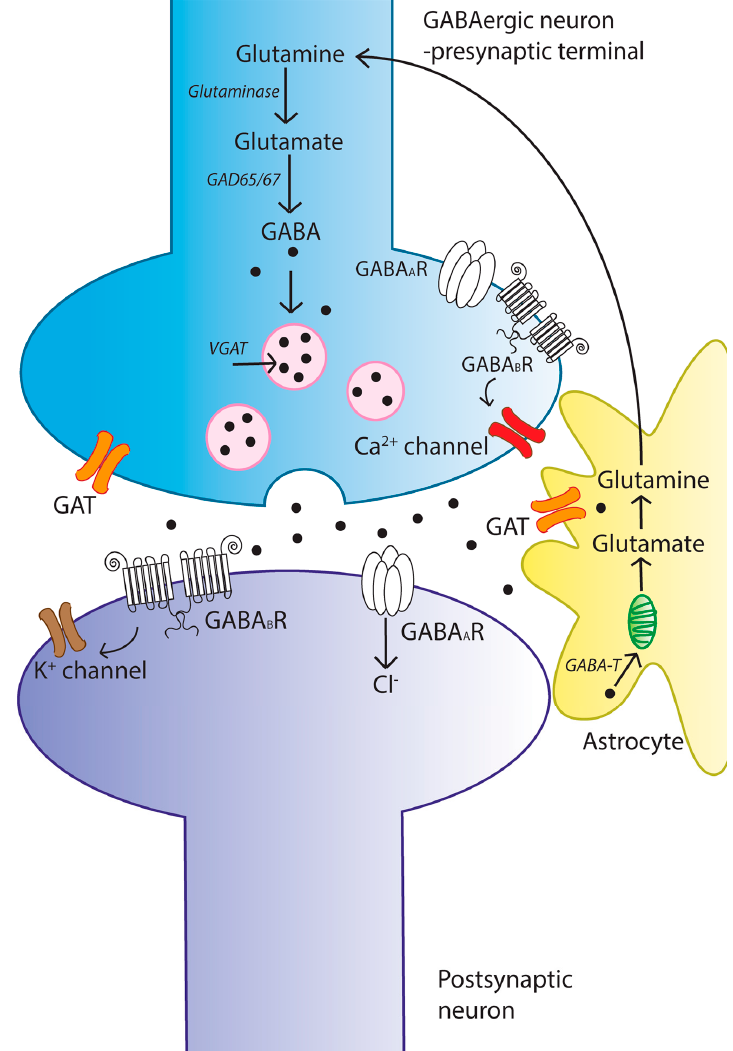
Figure 1. An overview of the γ -aminobutyric acid (GABA) signaling system. The schematic diagram represents a GABAergic synapse and depicts the key aspects of GABAergic signal transduction. GABA is synthesized in the pre-synaptic terminal from glutamate by glutamic acid decarboxylase (GAD). GABA is then recruited into synaptic vesicles via the action of vesicular GABA transporter (vGAT). Following membrane depolarization, GABA is released into the synapse and can bind to either ionotropic GABA A receptors (GABA A R) or metabotropic GABA B receptors (GABA B R) on the postsynaptic membrane, resulting in inhibition of the post-synaptic neuron. Released GABA is cleared from the synapse by membrane-bound GABA transporters (GATs), localized to neurons and astrocytes. In astrocytes, GABA is recycled into synaptic vesicles or taken up by mitochondria, where it is metabolized by GABA transaminase (GABA-T) to glutamine for neuronal uptake.